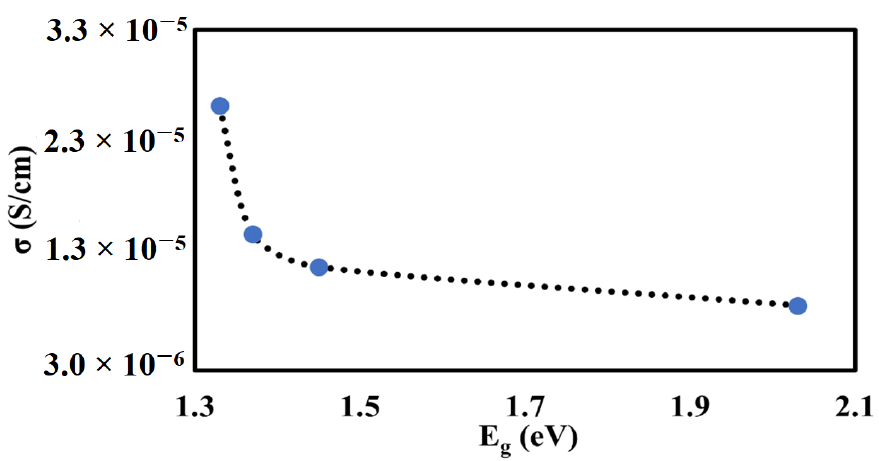
Figure 9. Graph showing the relationship of conductivity to band gap (E g ). Table 3. The conductivity values of the STC and STCM materials.